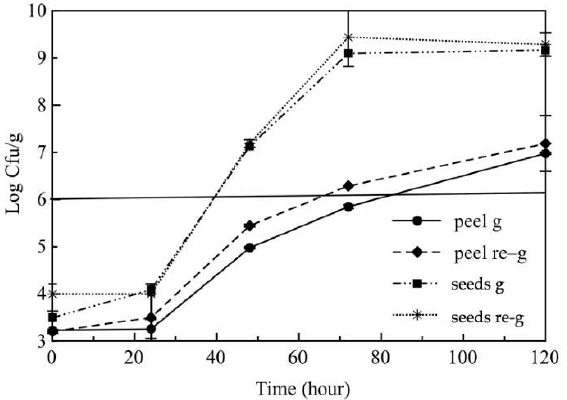
Figure 2. Evolution of Pseudomonas spp. viable cell concentration in broth with pomegranate ground peel powder (peel-g) and re-ground peel powder (peel re-g); ground seed powder (seed g) and re-ground seed powder (seed re-g).